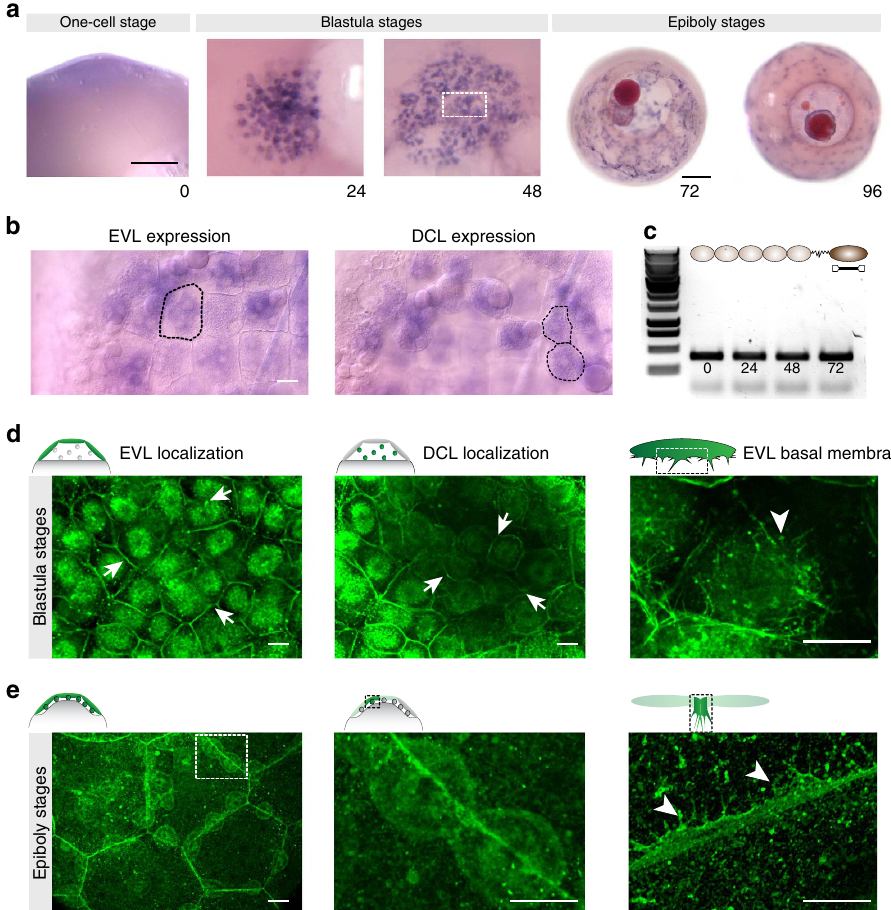
Figure 5 | e-cad mRNA expression and E-cad protein localization during blastula and epiboly stages of annual killifish. ( a ) Bright-field images of A. nigripinnis embryos after whole-mount in situ hybridization showing e-cad mRNA expression in violet from one-cell stage (0 h.p.f.) through blastula (24 and 48 h.p.f.) to epiboly (72 and 96 h.p.f.) stages. e-cad is expressed maternally. During blastula and epiboly stages, e-cad mRNA is detected at high levels in the EVL and DCL. All panels correspond to animal pole views with the exception of the 1-cell stage, which is a lateral view. ( b ) High-magnification views of the region depicted in a at 48 h.p.f. (dashed rectangle), showing the expression of e-cad in single cells of the EVL and DCL, outlined in left and right panels, respectively. ( c ) Semi-quantitative PCR showing the expression of a cDNA fragment of ± 300bp coding for a region of the cytoplasmic domain of E-cad. ( d ) Confocal microcopy optical sections showing the localization of E-cad protein during blastula stages, after indirect immunofluorescence using a specific antibody against A. nigripinnis E-cad. E-cad protein concentrates at the cell membrane (arrows) and peri-nuclear regions of the EVL and DCL, with additional localization in filopodial protrusions from the DCL and EVL basal surface (arrowheads). ( e ) Confocal microcopy z -stack maximum projections showing the localization of E-cad protein during epiboly stages. E-cad becomes primarily localized at the cell membrane in the EVL and DCL, with prominent localization at cell junctions and lamellipodial-like protrusions of the EVL basal surface at EVL cell borders (arrowheads in right panel). Scale bar, 250 m m ( a ) and 25 m m ( b , d , e